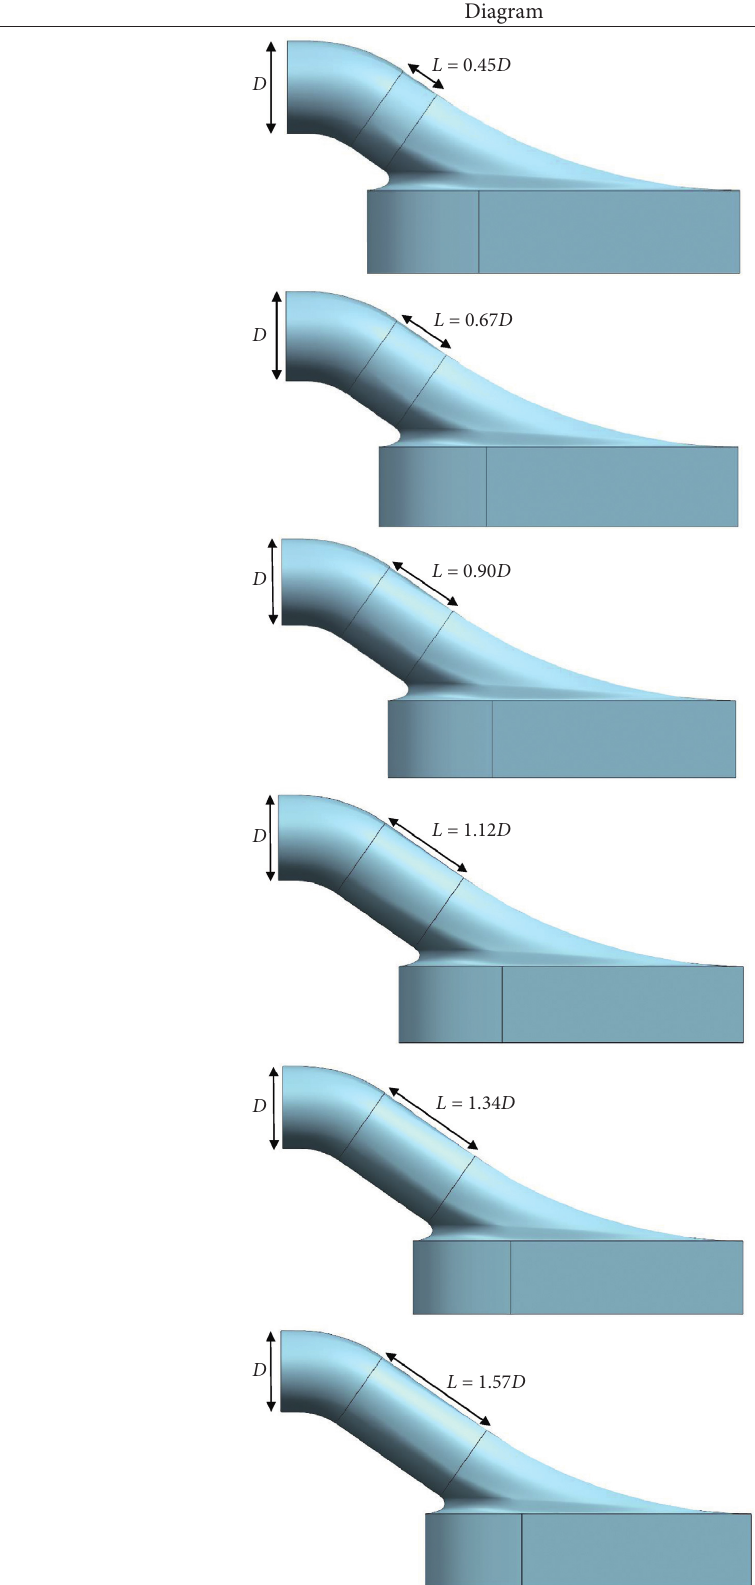
Table 2: Research